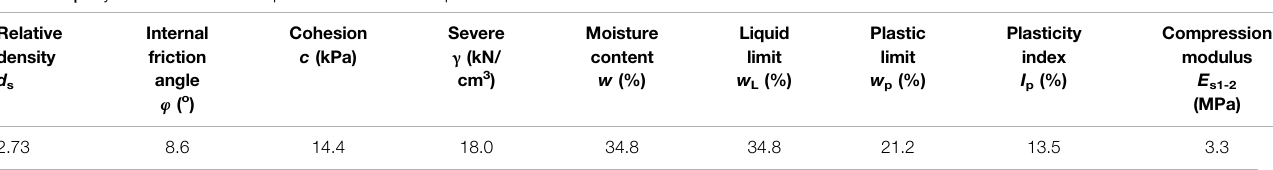
TABLE 1 | Physical and mechanical parameters of soil samples. Relative density d